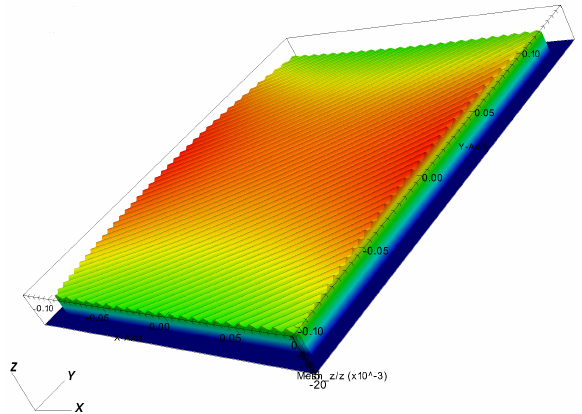
Figure 4. Losses of the 2 grating shapes for all linear polari- sation angles illuminating grooves perpendicular to the plane of incidence. Losses are normalised to perpendicular incidence on a plane mirror.